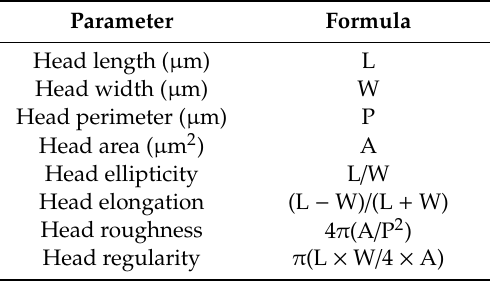
Table 1. Formulas used to calculate morphometric measurements of the sperm